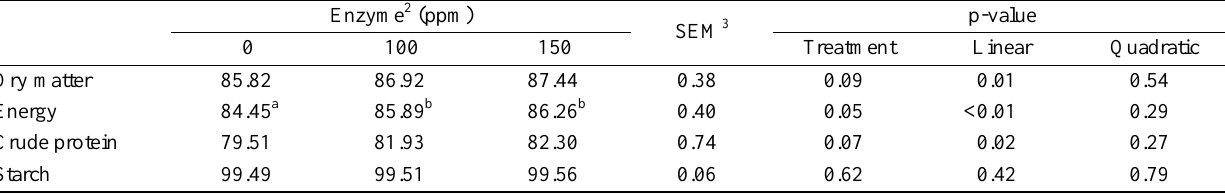
p-value SEM 3 Treatment Linear